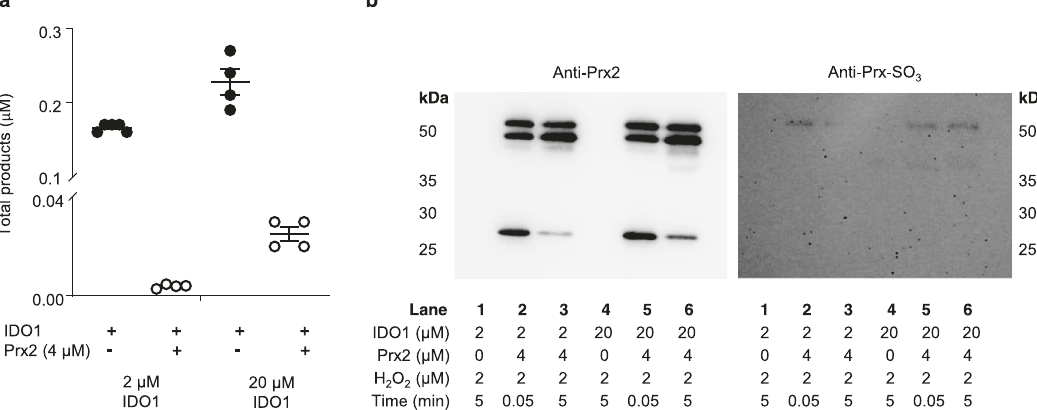
Fig. 6 Utilization of H 2 O 2 by IDO1 in the presence of Prx2. a IDO activity assays (IDO1, 2 or 20 µ M; H 2 O 2 2 µ M; L -Trp; 100 µ M) were carried out in the absence and presence of His-tagged Prx2 (4 µ M). Reactions were incubated for 5 min at 25 °C and H 2 O 2 -derived Trp oxidation products ( cis -WOOH and OIA) determined by LC-MS/MS. b Samples analyzed in ( a ) were collected and alkylated with NEM and probed by SDS-PAGE and western blotting for Prx2 oxidation state. Data are shown as mean ± SEM ( n = 4 independent enzyme assays). Source data are provided as a Source data